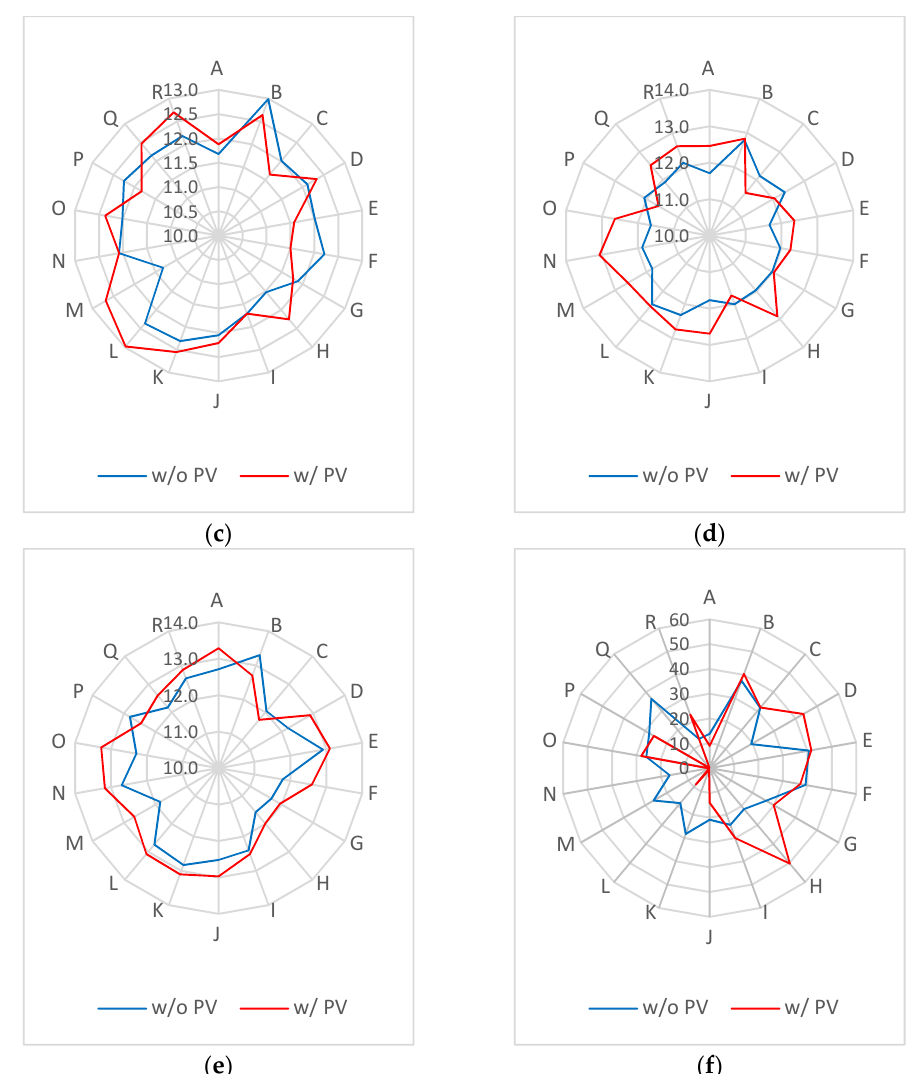
Figure 10. Comparison of measurements at the analyzed points: ( a ) battery voltage 1; ( b ) battery voltage 2; ( c ) battery voltage 3; ( d ) battery voltage 4; ( e ) battery voltage 5; ( f ) EV speed; (A–R points explained in Table 3). Table 4. Statistical data for each battery with PV (w/) and without (w/o). Data